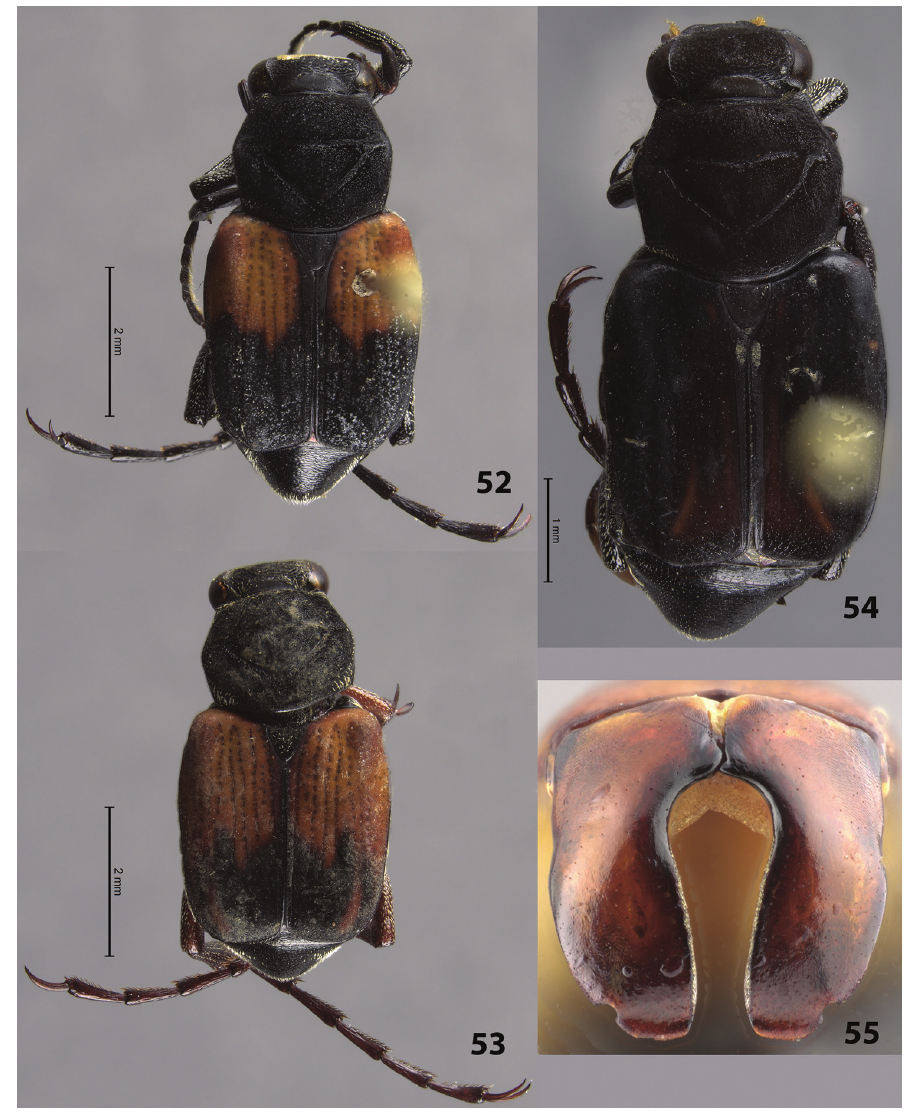
Figures 52–55. Trigonopeltastes simplex Bates, 1889, males from CMNC (label data: 52 “Guatemala, Zacapa / rd. to San Lorenzo, 4200’ / June 10-15, 1991 / E. Giesbert, coll.” 53 “GUAT. Baja Verapaz / 14.5km N.Salamá on / Pantín Rd. 1620 m / 23.V.1991 / H & A Howden” 54 “MEXICO, CHIAPAS